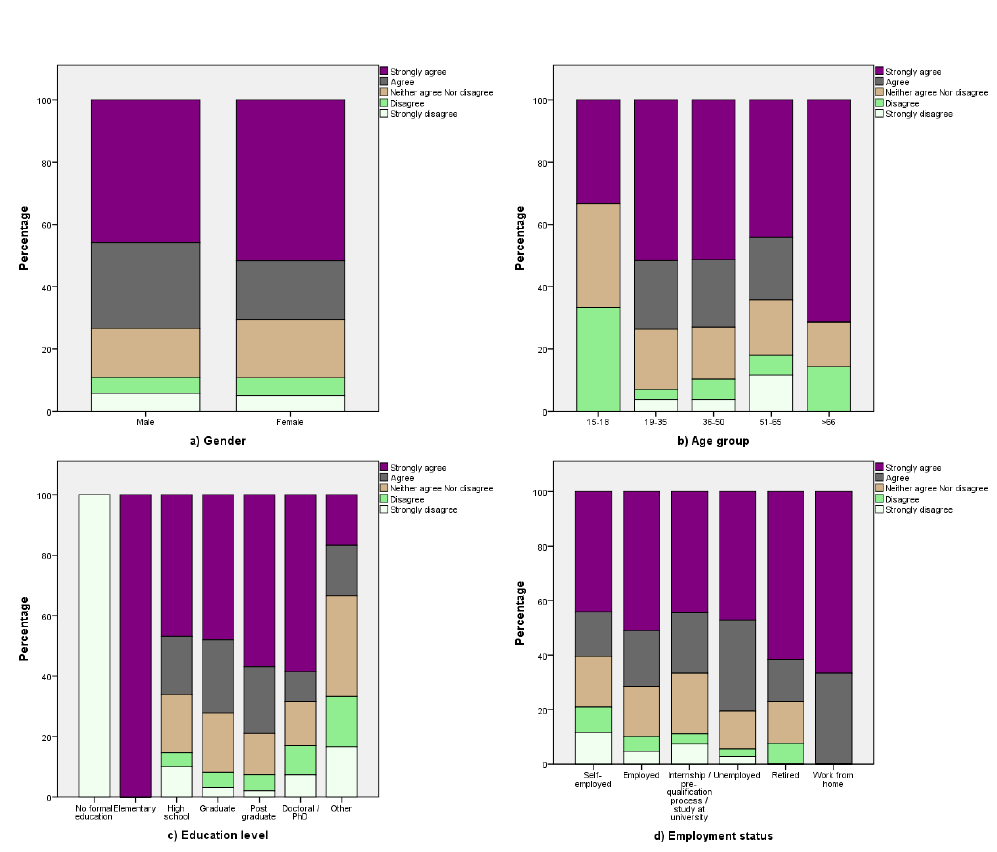
Figure 3. Opinion of the participants on changing or improving the current walk-in method by a) Gender, b) Age Group, c) Education Level, and d) Employment